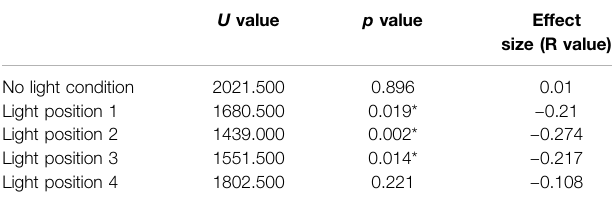
TABLE1| Mann-Whitney U testresultscomparingthetactilelocalisationbetween the random group and the structured group at the different light